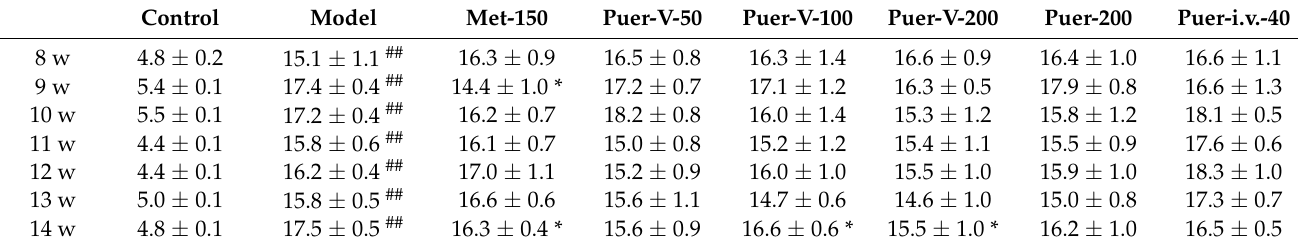
Table 1. Effect of puerarin-V on